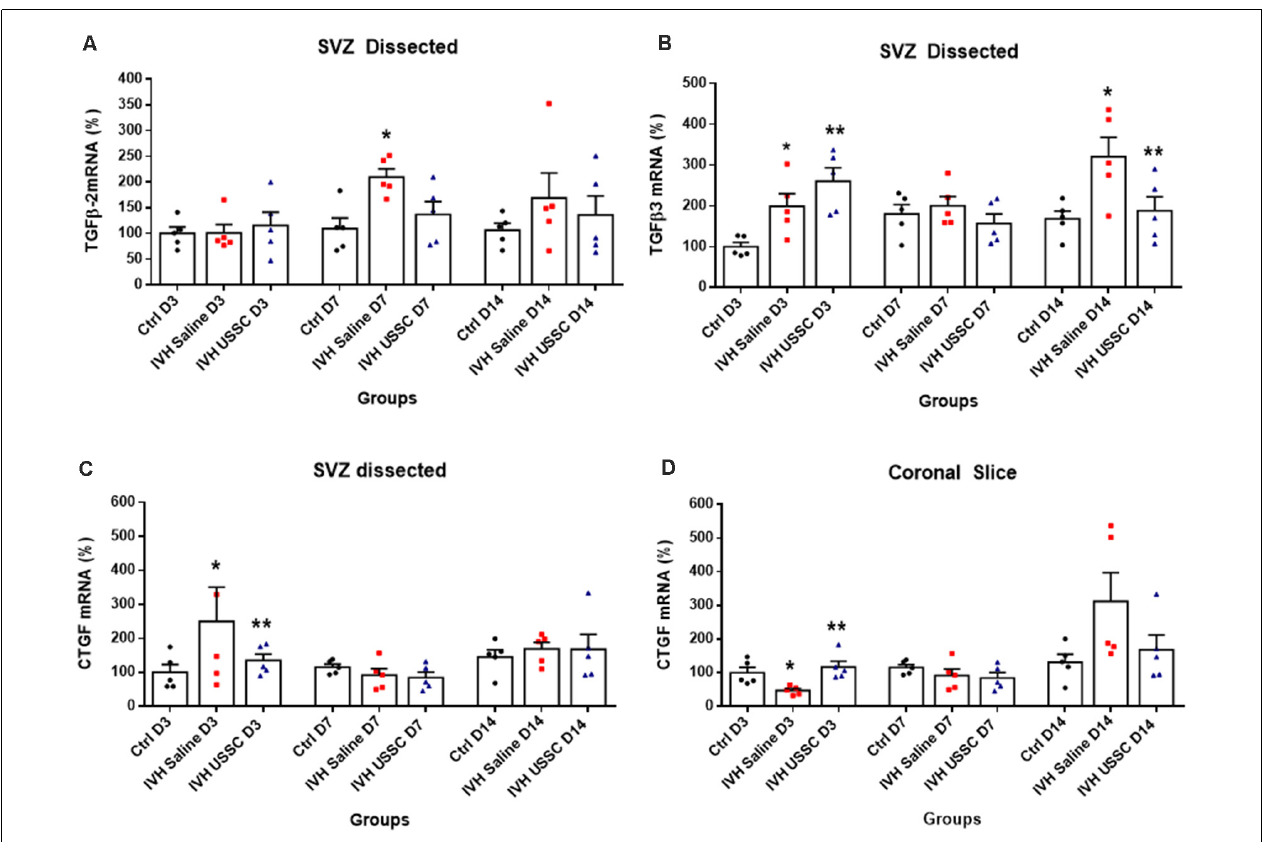
FIGURE 7 | USSC administration suppressed the expression of TGF- β isoforms and connective tissue growth factor (CTGF) mRNA in SVZ in PHH. (A,B) Scatter plot with bar graphs showing TaqMan gene expression assay in microscopic dissected SVZ tissue for TGF- β isoforms 2 and 3 mRNA. (A) Increased TGF- β 2 isoform mRNA was observed in IVH pups on postnatal 7th day, whereas it reduced after USSC treatment ( ∗ P < 0.05, Ctrl vs. IVH, n = 5 in each group). (B) Increased TGF- β 3 expression was observed on day 3 in IVH pups with and without USSC treatment ( ∗ P < 0.05, Ctrl vs. IVH, ** P < 0.05 for Ctrl vs. USSC, IVH vs USSC, Ctrl vs. USSC, n = 5 in each group). On postnatal day 14, TGF- β 3 significantly increased in IVH pups compared to control and was reduced to normal levels after USSC treatment ( ∗ P < 0.05, IVH vs. USSC, ** P < 0.05 for IVH vs. USSC, n = 5 in each group). The data represent mean ± SEM; for each group for three postnatal days 3, 7 and 14. P -values were derived by one-way ANOVA with Tukey’s multiple comparisons test. (C,D) Scatter plot with bar graphs showing TaqMan gene expression assay in microscopic dissected SVZ tissue and total coronal slice for CTGF mRNA levels. (C) CTGF mRNA was increased in IVH pups on day 3 in SVZ and suppressed to normal levels after USSC treatment and was comparable on 7th and 14th day (* P < 0.05 for Ctrl vs. IVH and ** P < 0.05 for IVH vs. USSC at day 3, n = 5 in each group). (D) CTGF mRNA was increased in coronal slice on day 14 after IVH while USSC administration reduced CTGF after IVH on day 14 (* P < 0.05 for Ctrl vs. IVH and ** P < 0.05 for IVH vs. USSC on day 3, n = 5 in each group). The data represent mean ± SEM; for each group for three postnatal days 3, 7 and 14. P -values were derived by one-way ANOVA with Tukey’s multiple comparisons